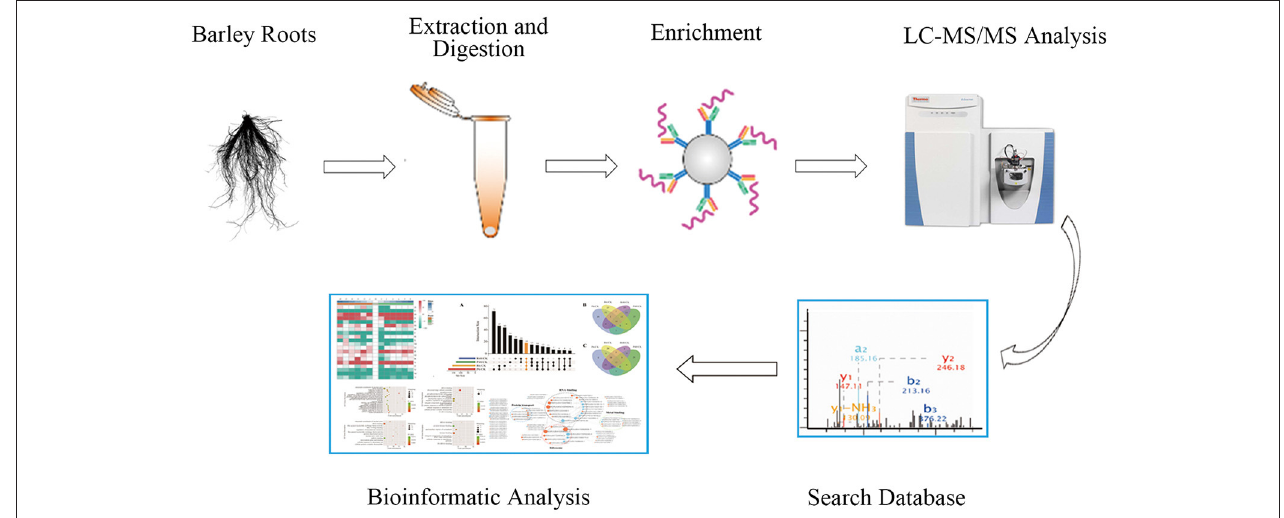
FIGURE 1 | The workflow of integrated strategy for global mapping of phosphorylation in barley